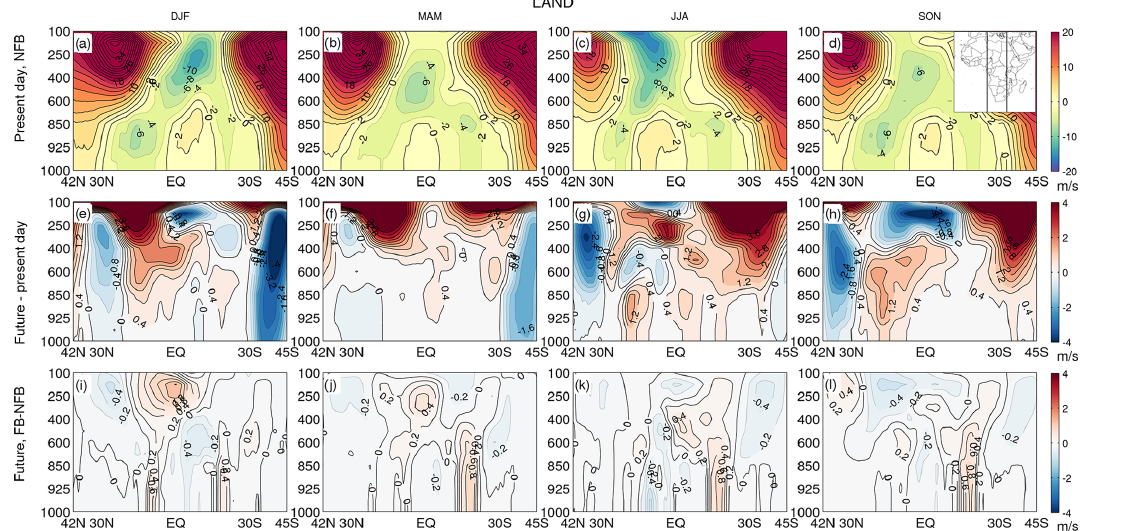
Figure 7. Same as Fig. 6 but for the longitudinal band over land (10–30 ◦ E; see the inset in d ).